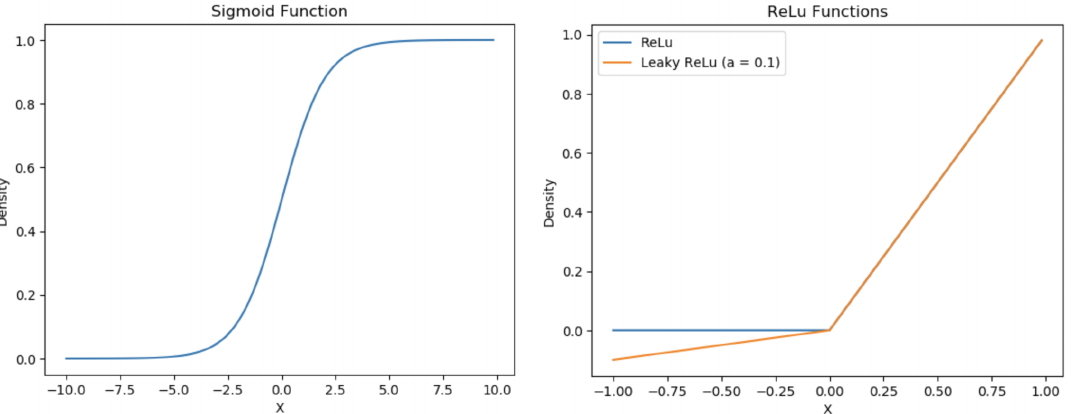
Figure 2. Activation functions. On the l.h.s., the most commonly used sigmoid activation function. On the r.h.s., ReLU and leaky ReLU functions as in (5). The difference between the ReLU functions is in the negative part of the function, where in the case of leaky ReLU (red line), a can take a small value (0.01), while for ReLU, a is